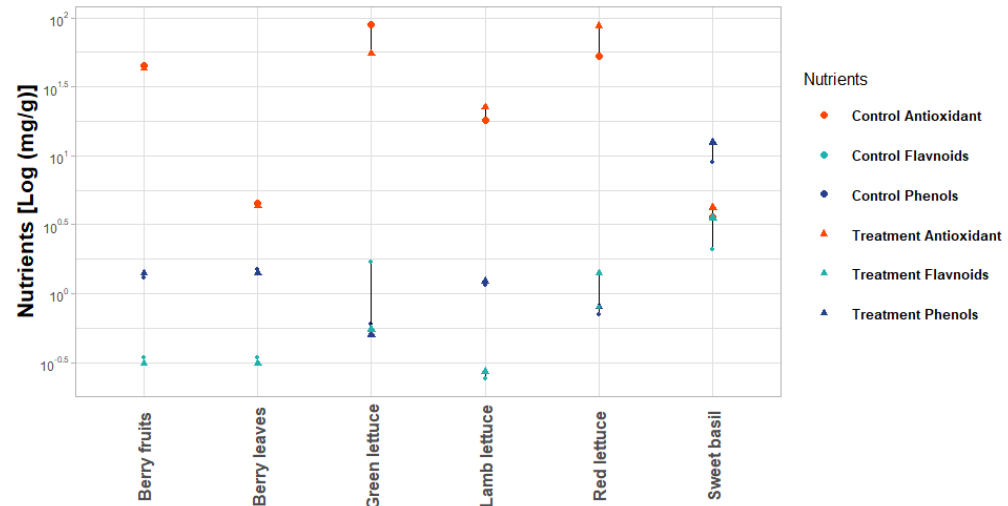
Figure 3. Impact of different LED illumination spectra on the nutrient’s parameters, namely, treatment antioxidant, treatment flavonoids, treatment phenols, treatment flavonoids, and control antioxidant, control flavonoids, control phenols for various vegetables and herbs in a grow chamber [55–57]. Plant traits were log-transformed due to significant variation in different treatments among species (phenols, flavonoids, antioxidant).